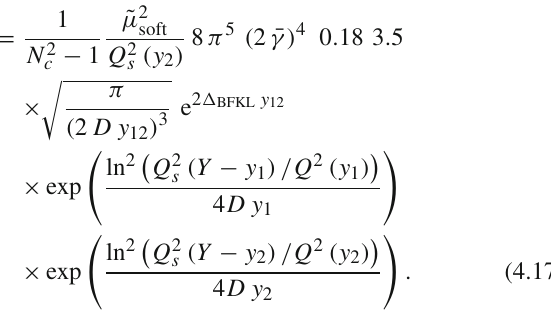
Fig. 4 The ratio of Eq. (4.17) at W=13 TeV versus y 12 , assuming that theexperimenthasasymmetricpatternwith Y − y 1 = y 2 = 1 The dotted line in a is for the estimates for the y 12 dependence of the Bose–Einstein contribution at small y 12 [11,76]. a and b The estimates